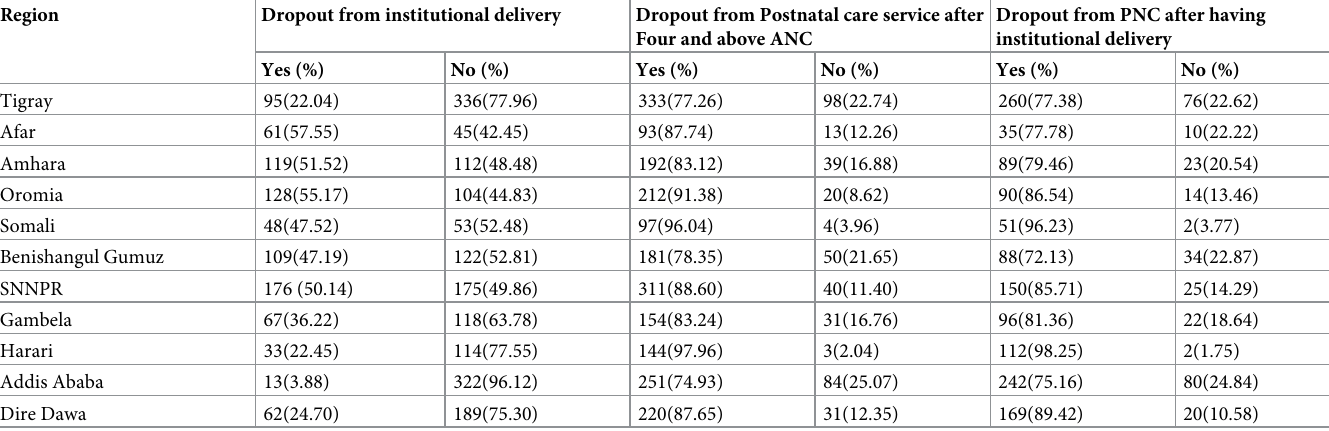
Table 3. Regional variation of dropout proportion from a place of delivery and postnatal care visit among women who had four and above ANC (N = 2601). Region Dropout from institutional delivery Dropout from Postnatal care service after